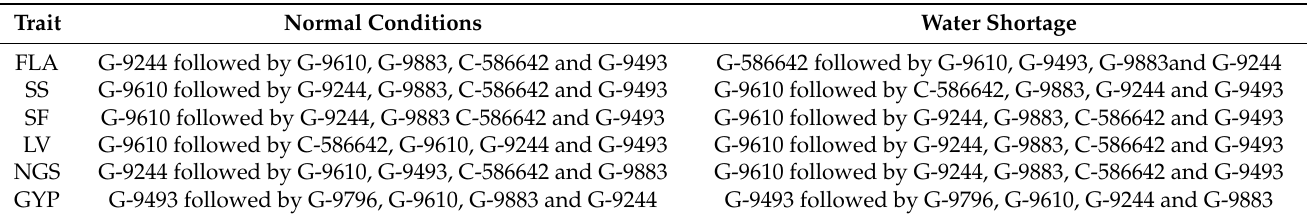
Table 4. Best performance wheat genotypes under both environments on data averaged over years.